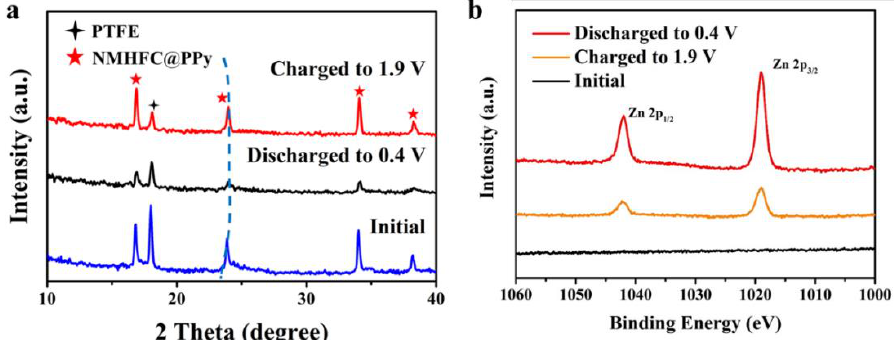
Figure 5. ( a ) Ex situ XRD and ( b ) ex situ XPS patterns of NMHFC@PPy cathode material during the first cycle in different